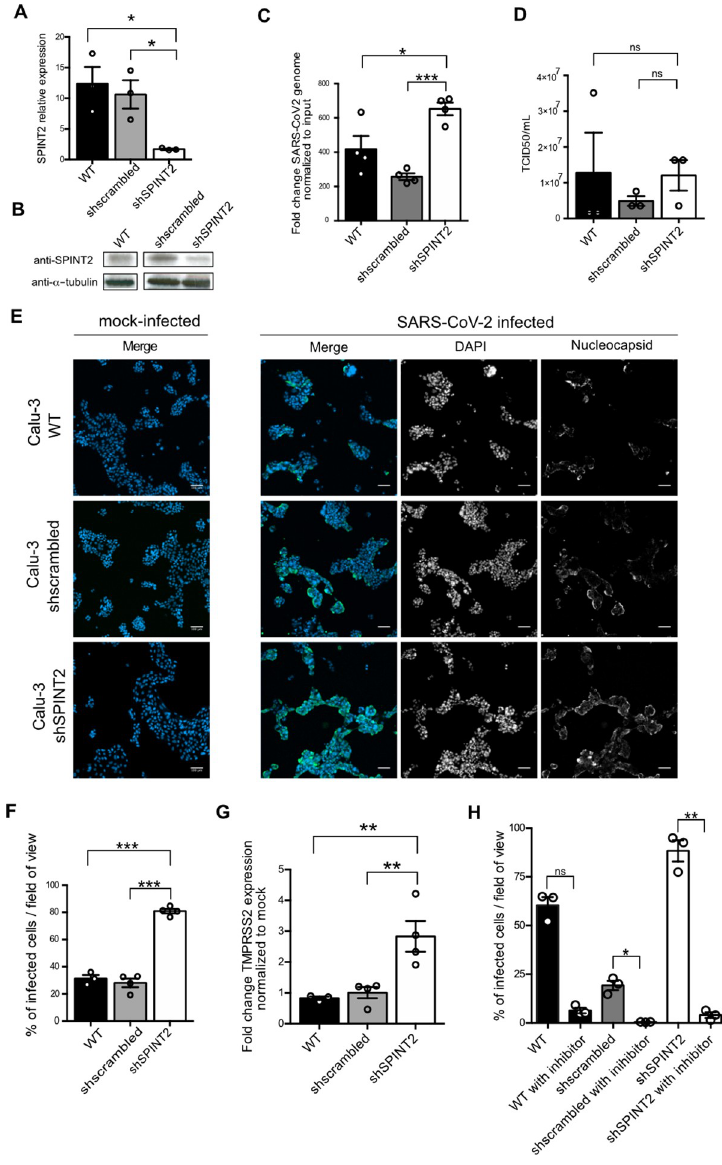
Fig 3. SPINT2 knockdown in Calu-3 cells promotes SARS-CoV-2 infection. A. Relative expression of SPINT2 normalized to the housekeeping gene TBP in wild type Calu-3, scrambled-treated and SPINT2 KD Calu-3 cells. B. Western blot of SPINT2 and α -tubulin as control in wild type, sh-scrambled and SPINT2 KD Calu-3 cells. C. Quantification of SARS-CoV-2 replication. RNA was harvested at 24hpi, and q-RT-PCR was used to evaluate the copy number of the SARS-CoV-2 genome. Data are normalized to inoculum used for infection. D . Quantification of de- novo virus particles released by WT, sh-scrambled and SPINT2 KD cells. E. Representative immunofluorescence images of Calu-3 wild type (WT) cells and cells treated with scrambled control shRNA (sh-scrambled) and shRNA targeting SPINT2 (shSPINT2) for mock-infected and SARS-CoV-2 infected conditions. Infection was detected by indirect immunofluorescence against the nucleocapsid N and Nuclei were stained with DAPI . F . Quantification of the percentage of SARS-CoV-2 infected cells from C. G . Quantification of TMPRSS2 expression upon SPINT2 silencing. q- RT-PCR was used to evaluate the expression level of TMPRSS2 in WT, sh-scrambled and SPINT2 KD Calu-3 cells. Relative expression level of TMPRSS2 in SARS-CoV-2 infected cells normalized to that of the mock-infected cells. H. Quantification of the percentage of SARS-CoV-2 infected cells for WT, sh-scrambled and SPINT2 KD Calu-3 cells mock-treated or treated with the TMPRSS2 inhibitor camostat mesylate. Infection was detected by indirect immunofluorescence using an anti-nucleocapsid antibody at 24hpi. Data are normalized to inoculum used for infection. Error bars indicate standard deviation. n = 3 biological replicates. P < 0.05 � , P < 0.01 �� , P < 0.001 ��� , P < 0.0001 ���� . Analysis was done by a two-tailed unpaired t-test with Welch’s correlation for the respective cell lines.